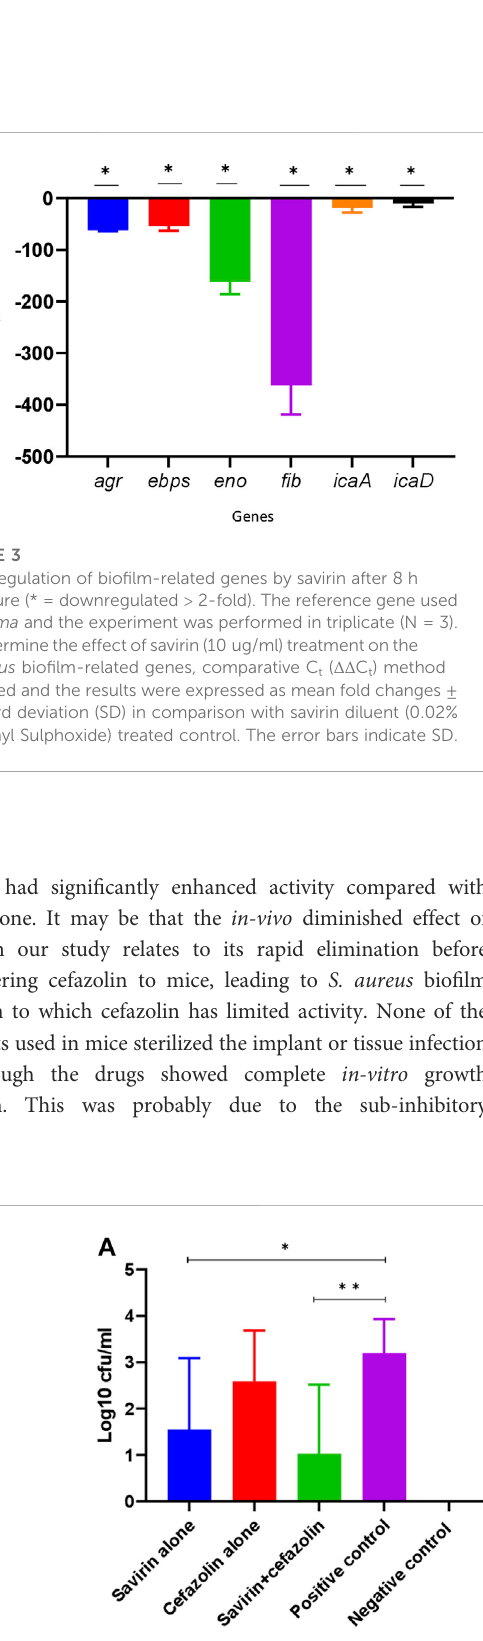
FIGURE 4 Bacterial counts on (N = 8) implant (A) and periprosthetictissue (B) of differentmice groups on day14 post-surgery (**= p < 0.01, * = p < 0.05). Savirin alone reduced bacterial concentration on K-wire, while savirin plus cefazolin reduced bacterial concentration on both K-wire and periprosthetic tissue. The data are presented as mean log10 cfu/ml ± standard deviation (SD). The error bars indicate